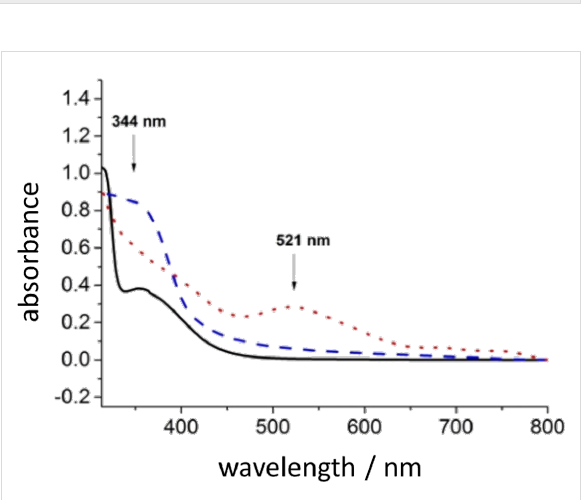
experiments. First, [Cp*Rh(bpy)H 2 O] 2+ was converted into